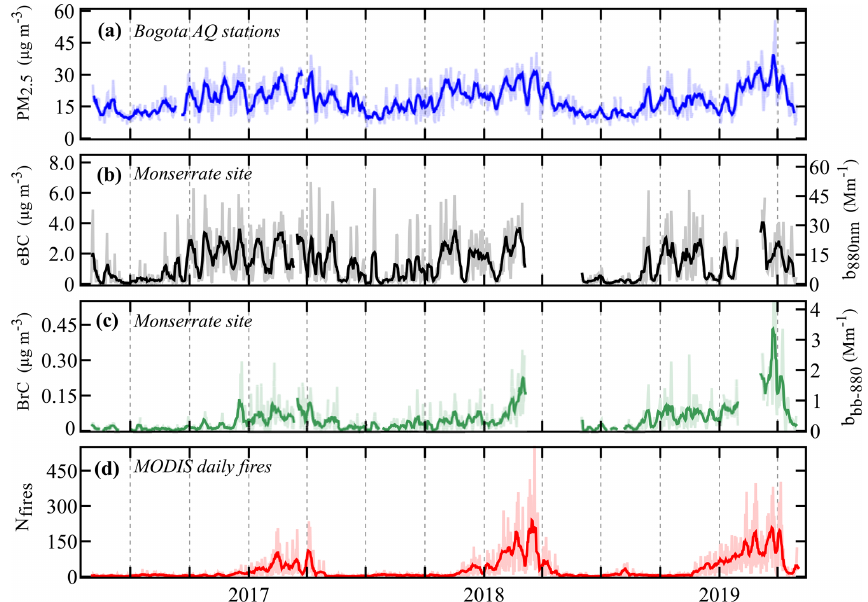
Figure 2. Time series of (a) PM 2 . 5 (µgm − 3 ) from Bogotá air quality monitoring stations, (b) equivalent black carbon (µgm − 3 ) from the Monserrate site (left axis is b abs , 880nm ; Mm − 1 ), (c) brown carbon (µgm − 3 ) from the Monserrate site (left axis is b bb , 880nm ; Mm − 1 ), and (d) daily MODIS active fire counts in NSA within 600 and 1000km of Bogotá. Thick lines are 7d moving averages from the original time series of daily mean values. Faded lines in all panels show daily mean